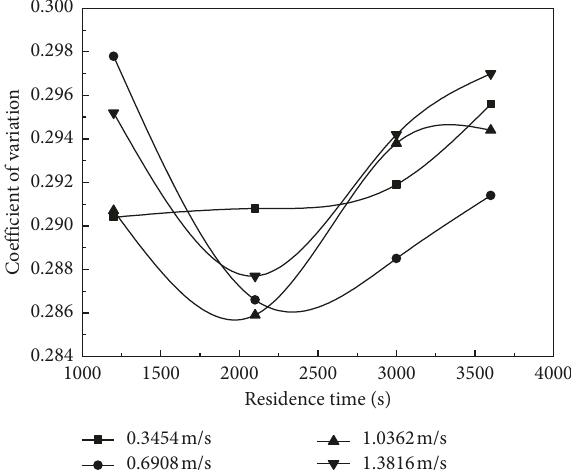
Figure 12: The influence of circulation flow rates on the coefficient of variation of crystal.